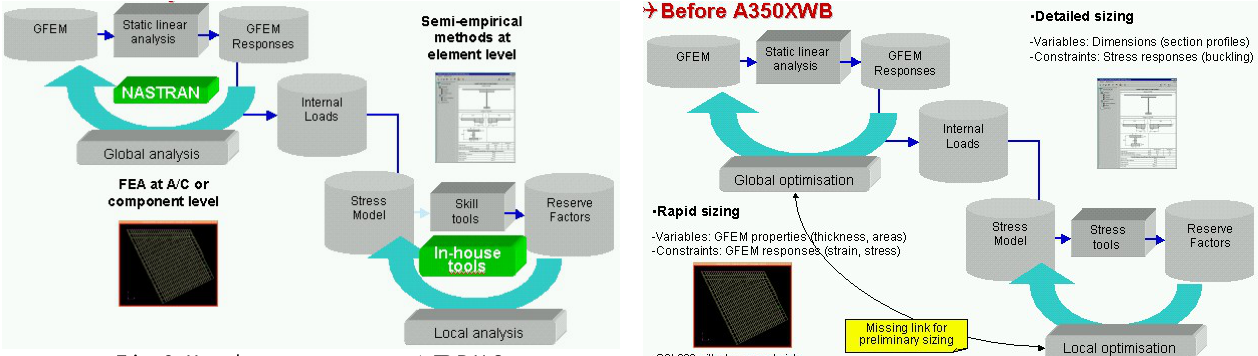
Fig. 6. Hand stress process at AIRBUS